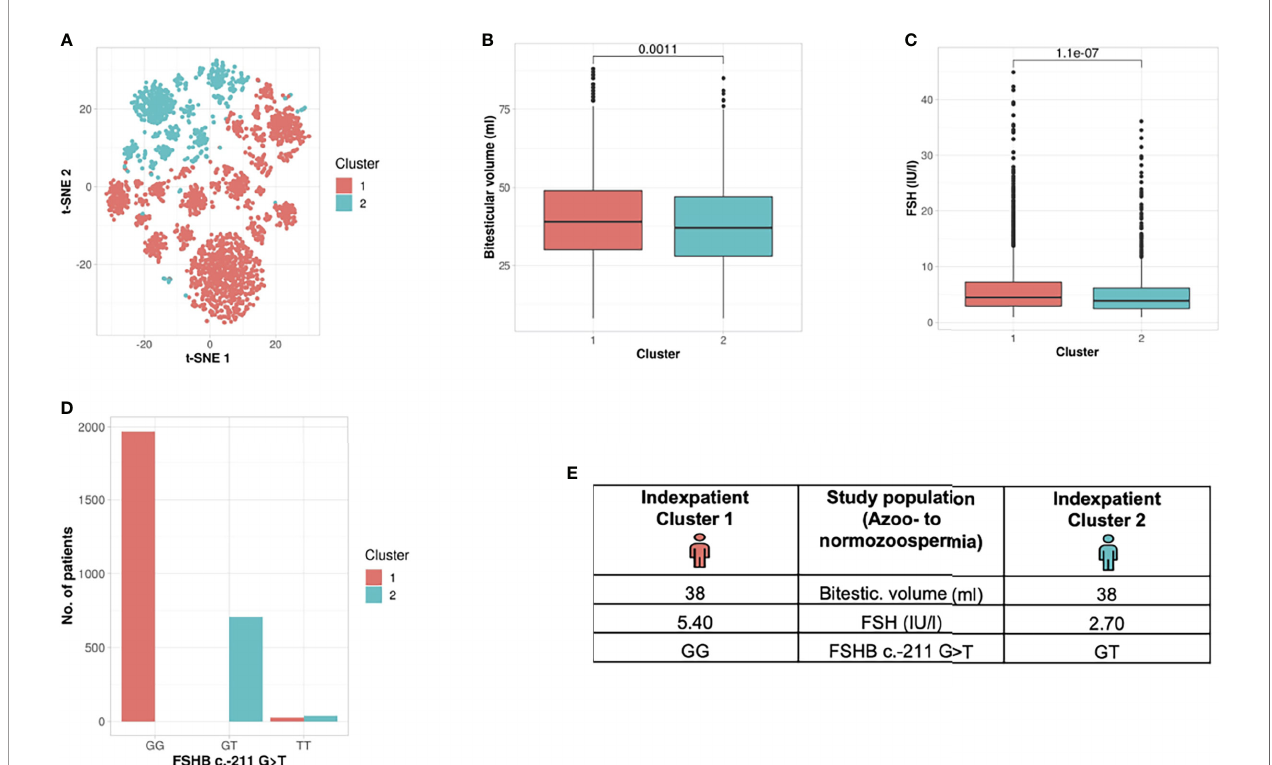
FIGURE 2 | Cluster analysis entire study population: Identi fi cation of two clusters and three segregation parameters (azoo- to normozoospermia). (A) Distribution of patients in the clusters. Each dot represents one patient of the entire cohort (n=2742). The distances between the patients are presented in two-dimensional space. Silhouette width is 0.16. (B – D) The andrologic parameters bi-testicular volume, FSH and FSHB c.-211 are the signi fi cant segregation markers between the two clusters. The boxes show the fi rst, second (i.e., median) and third quartiles of the respective parameters in Cluster 1 (comprising most individuals with GG) and Cluster 2 (comprising most individuals with a T allele). Outliers are shown as circles above the whiskers. The patients in the clusters differ signi fi cantly in regard to bi- testicular volume (p= 0.001 ) , FSH (p=1.1e-7), and FSHB c.-211 (p=2.2e-16). (E) Reproductive parameters of the index patient of Cluster 1 and 2. The index patient represents Cluster 1 or 2, respectively, with the parameters in which both clusters differ signi fi cantly. (The presented values do not necessarily match the median or mean of all parameters in the